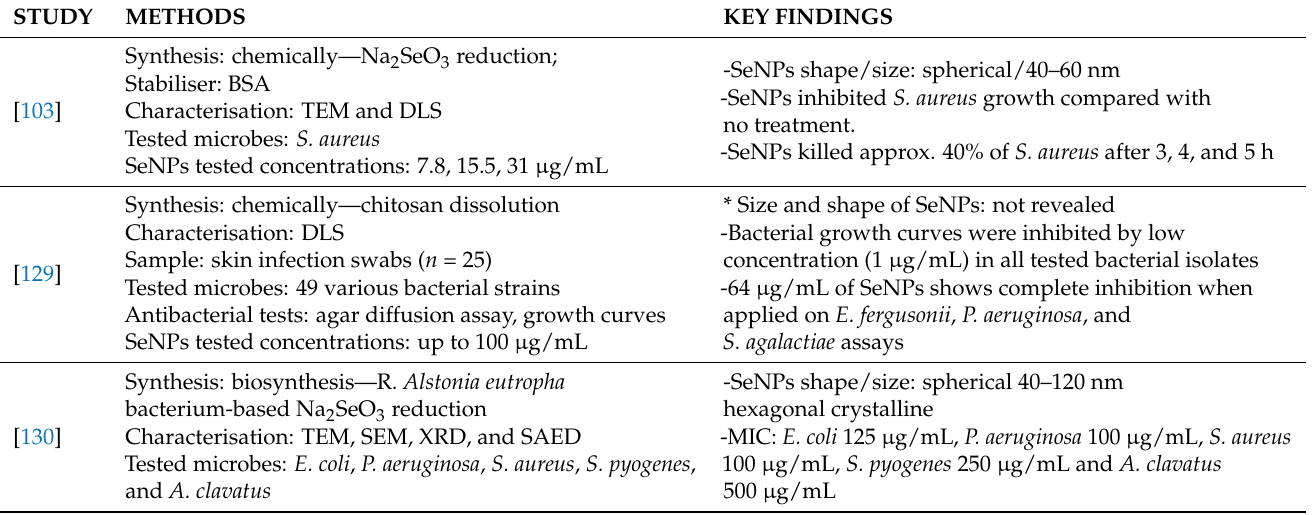
Table 1. Summary of published research on antimicrobial action of selenium nanoparticles. STUDY METHODS KEY